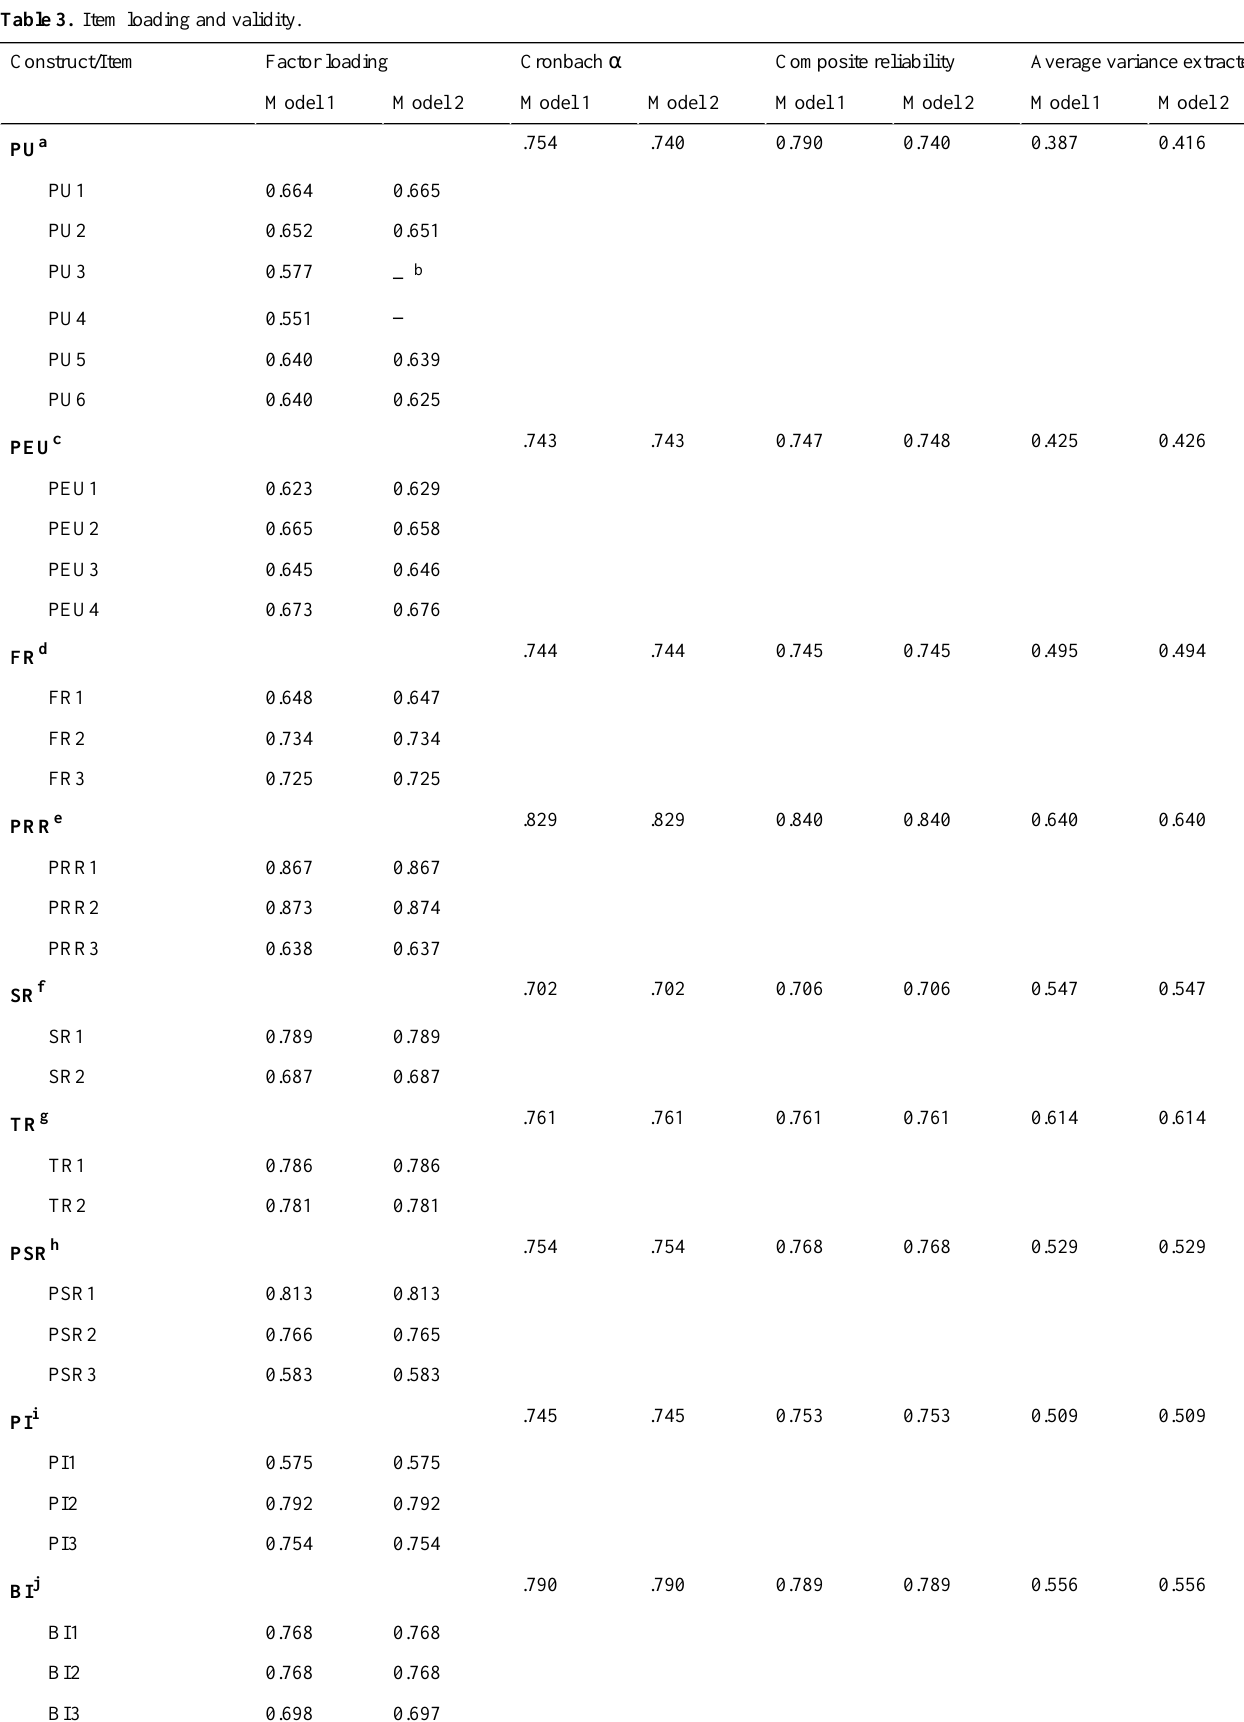
Table 3. Item loading and